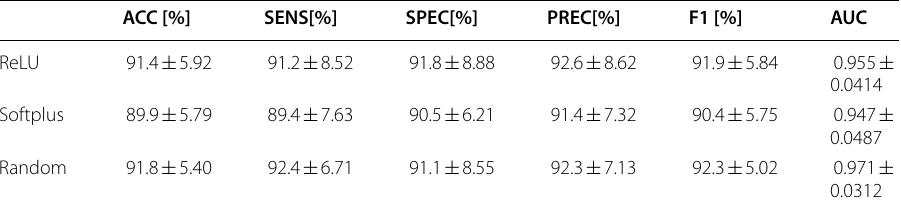
Table 1 The statistics (average STD) of the quality measures of the melanoma versus non- ± melanoma recognition obtained in 10 repetitions of the experiments